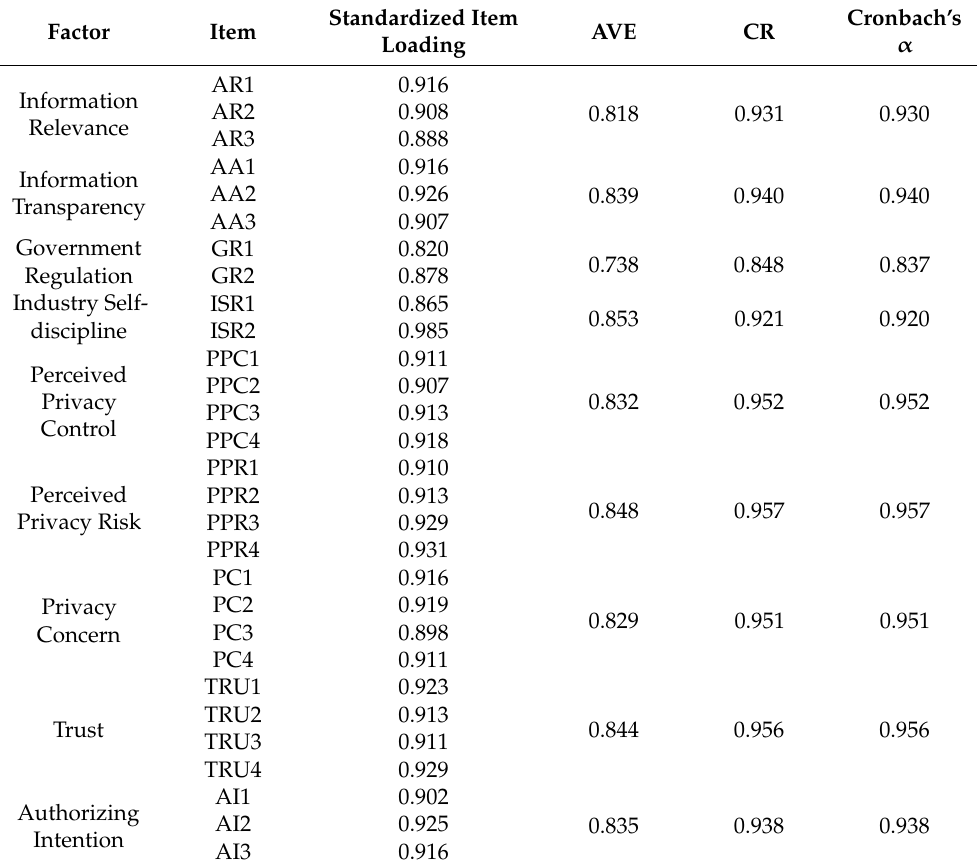
Table 3. Standardized item loadings, AVE, CR and Alpha